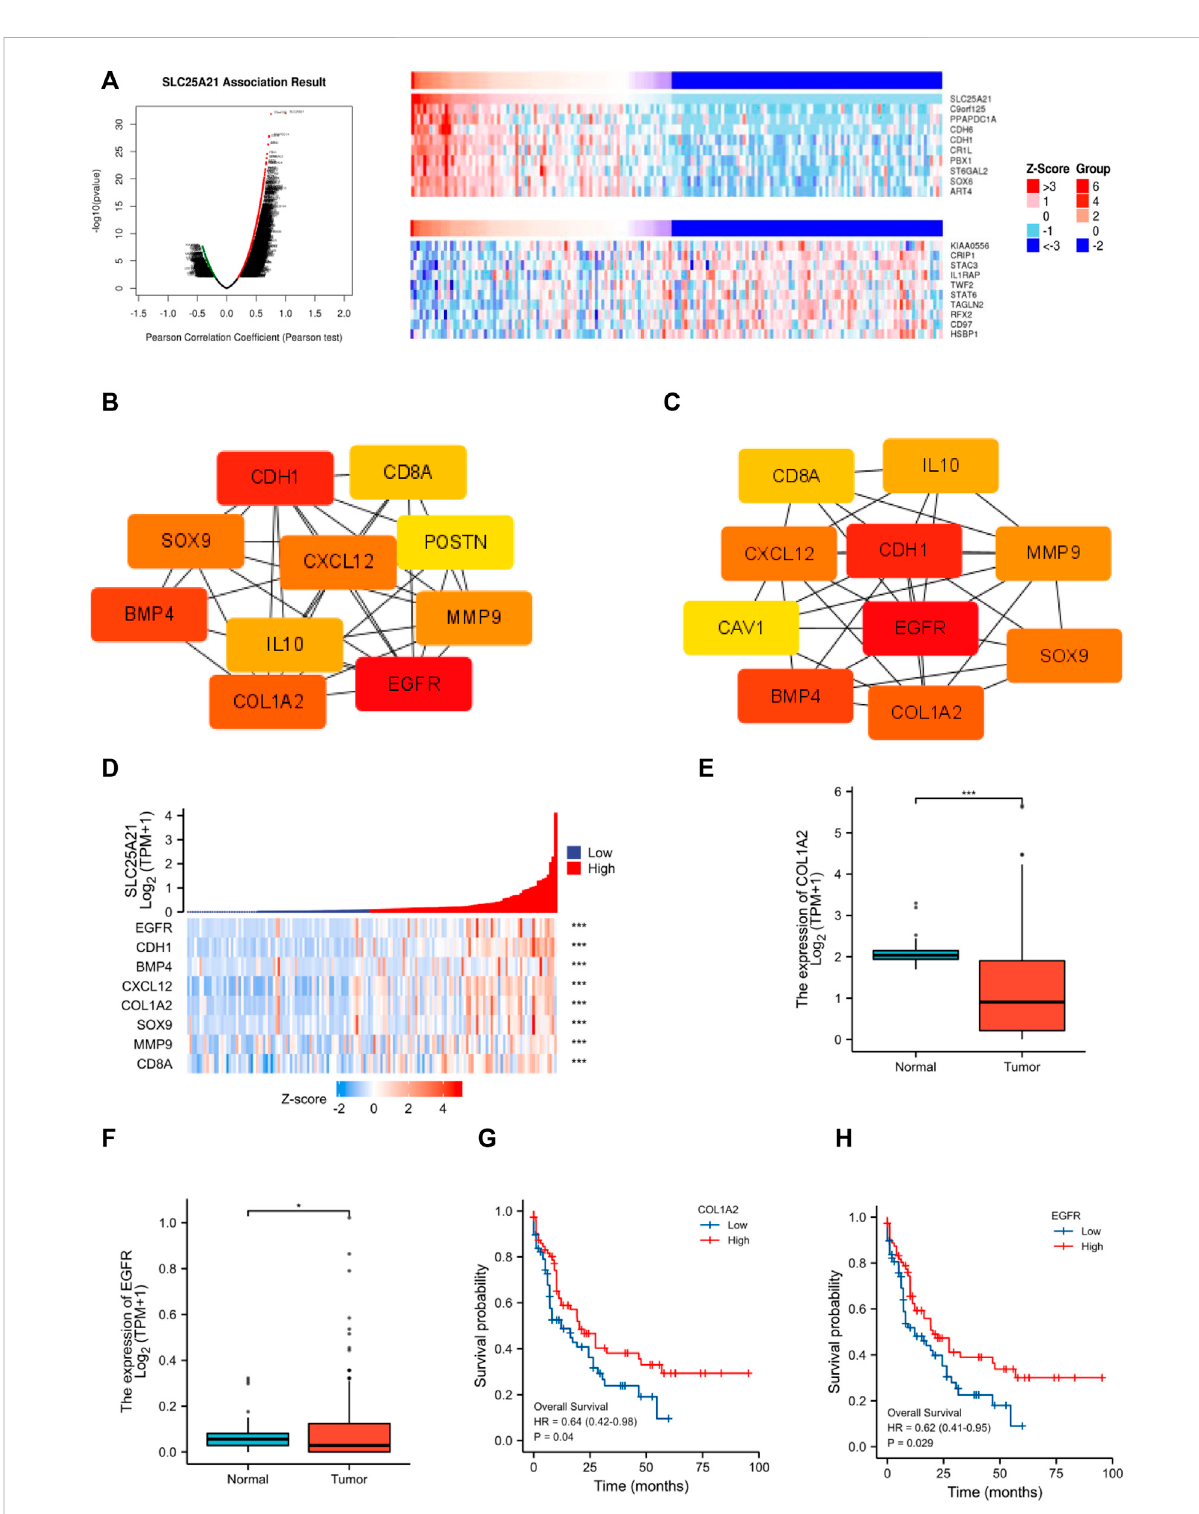
FIGURE 5 PPI network construction and clinical signi fi cance of hub genes. (A) Coexpression analysis of SLC25A21 in the TCGA-LAML dataset. The top 10 positively/negatively correlated genes are displayed. (B – C) The top 15 hub genes were selected on the basis of (B) MNC and (C) degree. (D) The association of SLC25A21 with eight hub genes (EGFR, CDH1, BMP4, CXCL12, COL1A2, SOX9, MMP9, and CD8A). (E) Expression levels of COL1A2 in AML patients ( n = 132) and normal participants ( n = 70). (F) Expression levels of EGFR in AML patients ( n = 132) and normal participants ( n = 70). (G) The difference in OS between patients with high and low COL1A2 expression levels shown by Kaplan-Meier curves. (H) The difference in OS between patients with high and low EGFR expression levels shown by Kaplan-Meier curves. (*, p < 0.05; **, p < 0.01; ***, p <